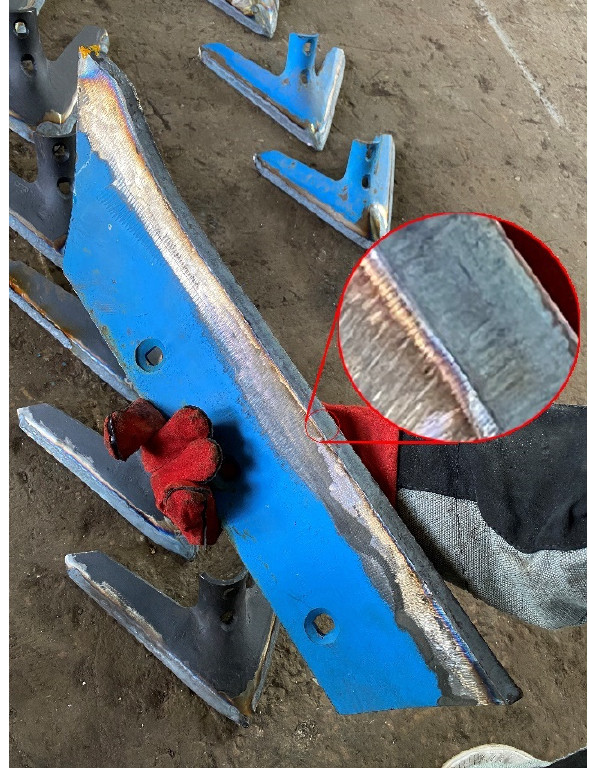
Figure 5. The appearance of the plasma-hardened ploughshare.